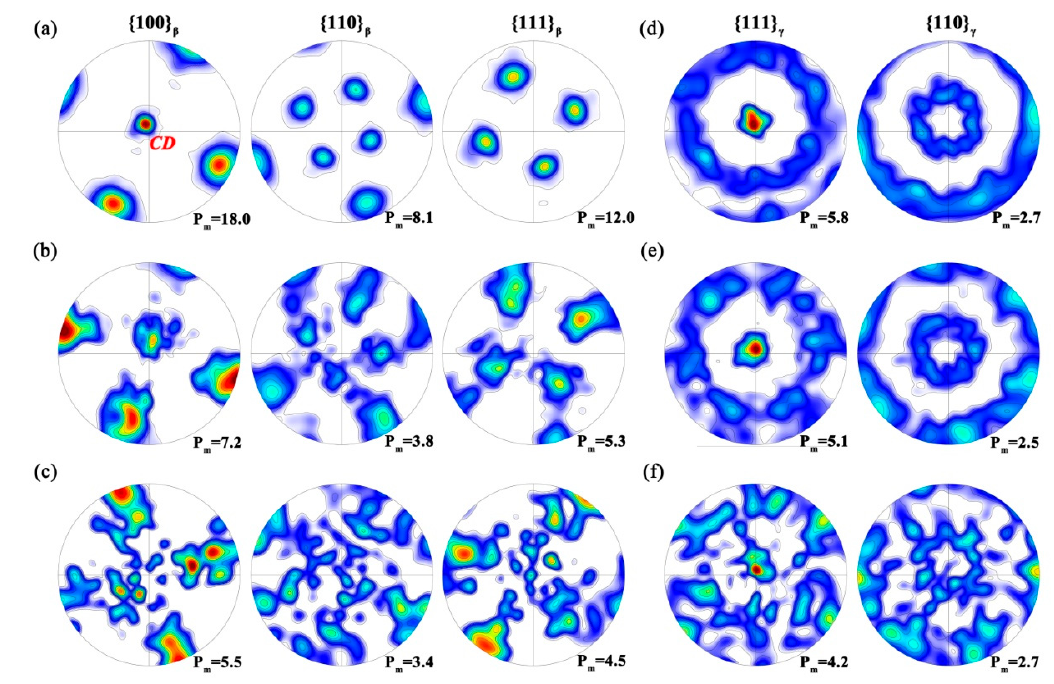
Figure 5. Pole figurs for ( a – c ) β and ( d – f ) γ phase at 1050 °C under ( a , d ) 0.5 s − 1 ; ( b , e ) 0.05 s − 1 and ( c , f ) 0.005 s − 1 . The maximum intensity is listed in the bottom-right for each pole figure.